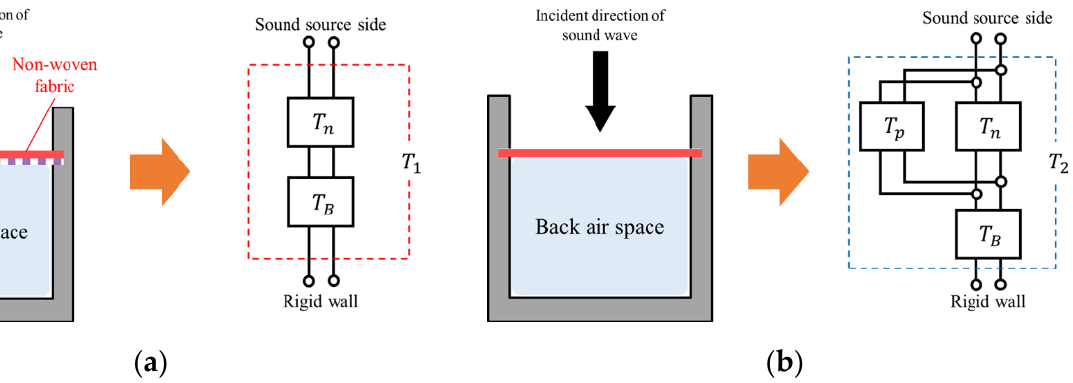
Figure 5. Equivalent circuits corresponding to test samples: ( a ) framed nonwoven fabric; ( b ) nonwo- ven fabric sheet.